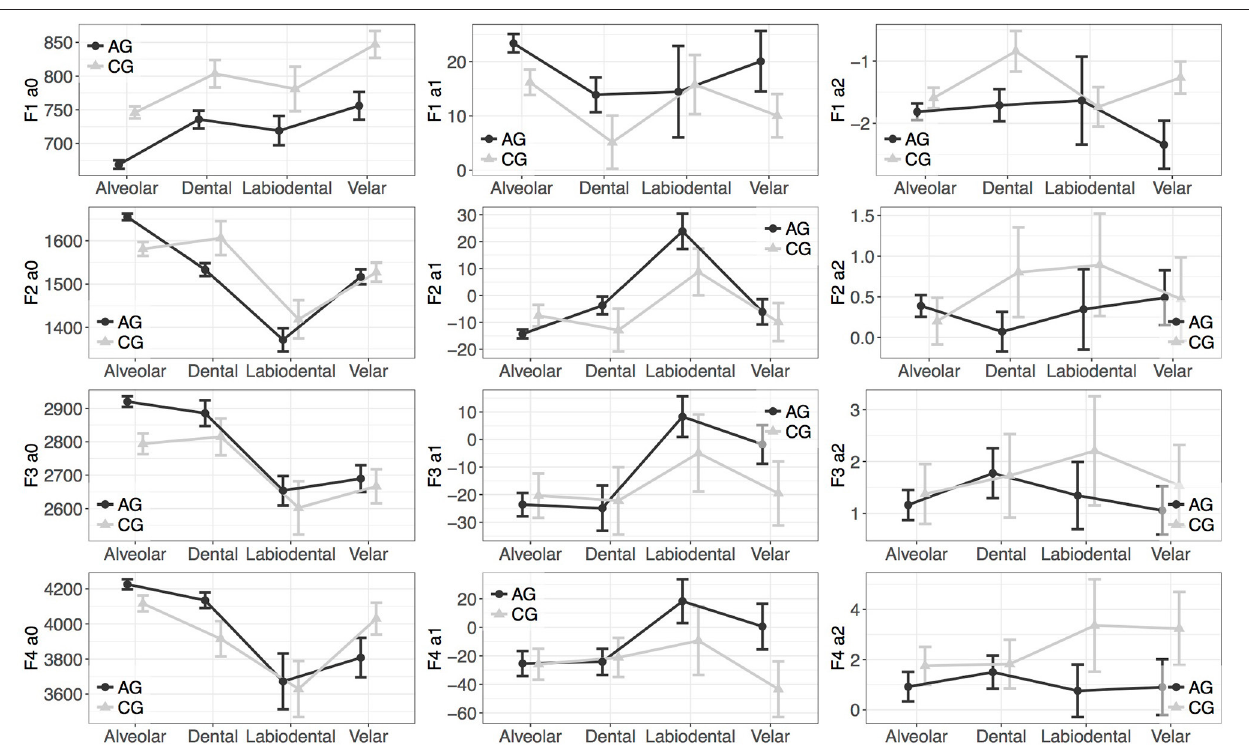
FIGURE 7 | Means and SD of the polynomial coefficients of the vowel formants of /a/, preceded by the unstressed voiceless alveolar, dental, labiodental, and velar